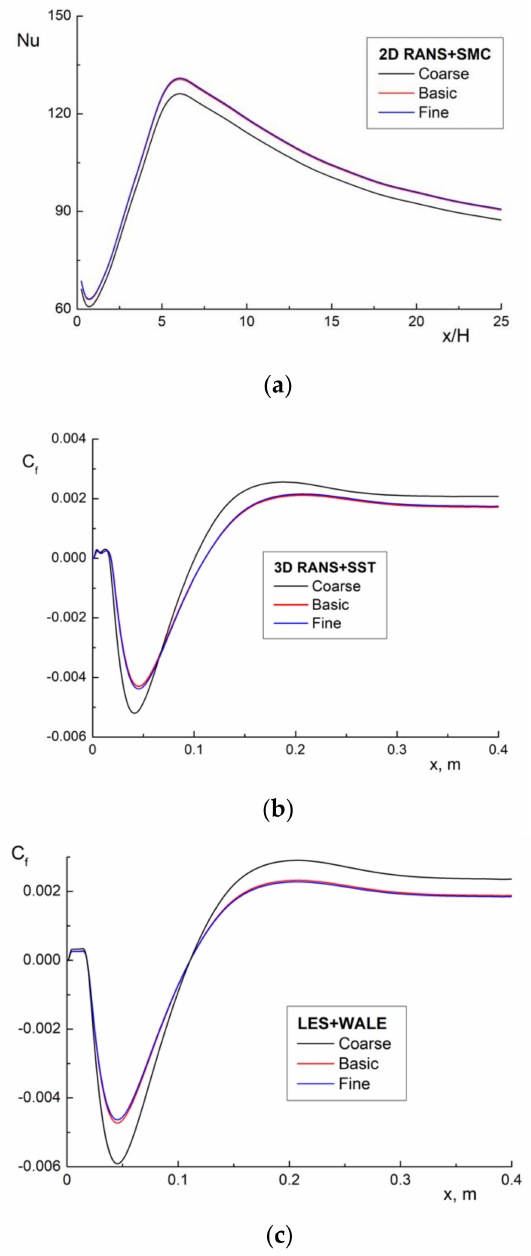
Figure 3. Grid convergence test of 2D RANS + SMC “in-house” code for the bubbly flow at T W = 313 K, T 1 = T b 1 = 293 K, β = 5%, d 1 = 3 mm ( a ), single-phase fluid flow 3D RANS+SST ( b ) and LES+WALE ( c ) in a duct with sudden expansion. Re H = 6600, ER =